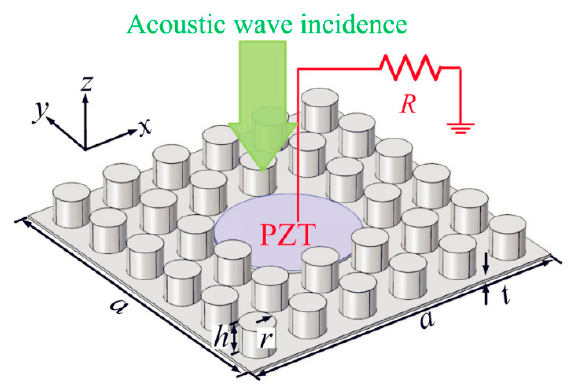
Figure 18. Schematic diagram of the planar acoustic metamaterial-based AEH. Reproduced with permission from [56]; published by American Institute of Physics, 2016.